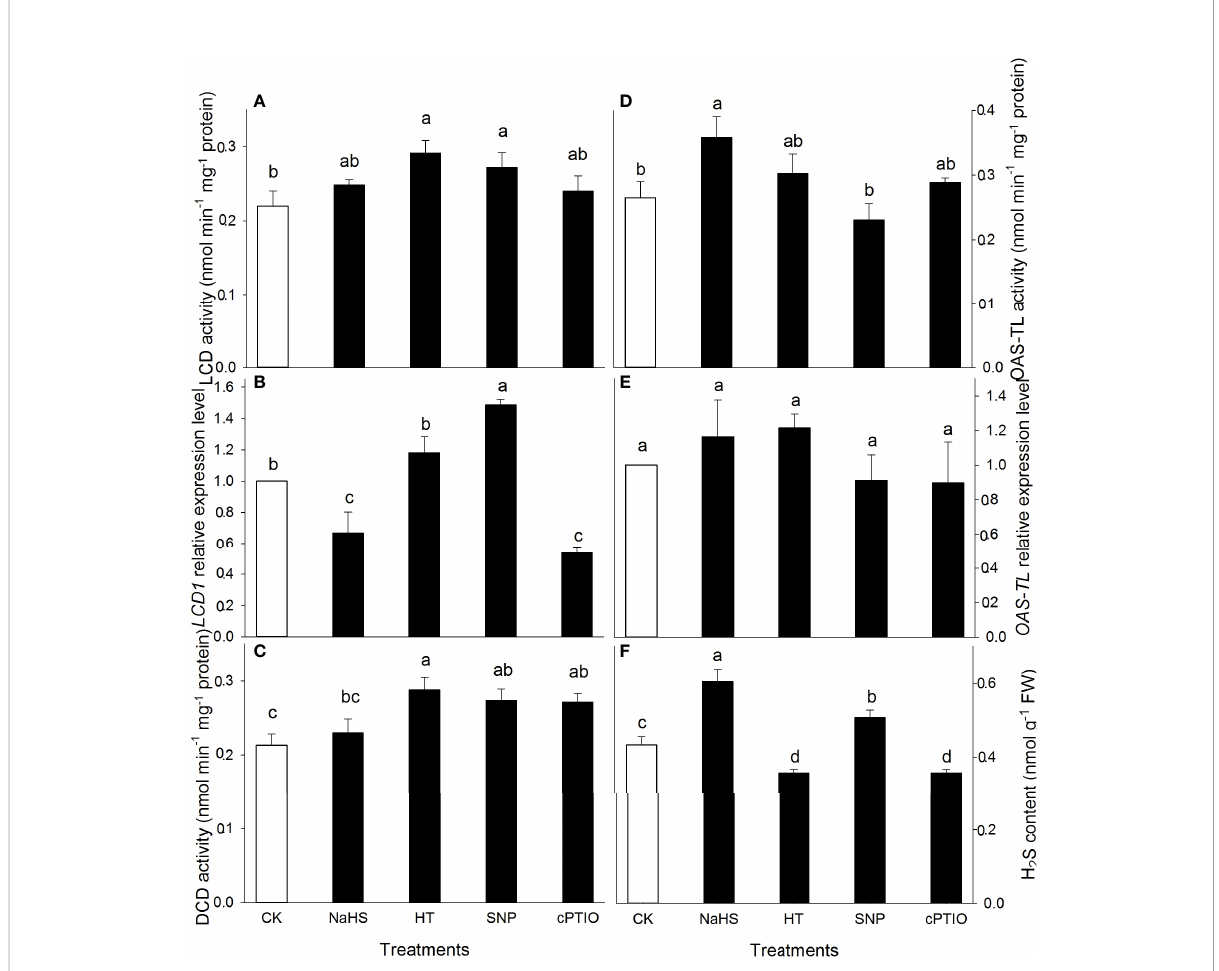
FIGURE 1 Effect of sodium hydrosul fi de (NaHS), hypotaurine (HT), sodium nitroprusside (SNP), and 2-(4-carboxyphenyl)-4,4,5,5-tetramethylimidazoline-1- oxyl-3-oxide (cPTIO) on L-cysteine desulfhydrase (LCD) (A) , D-cysteine desulfhydrase (DCD) (C) , O-acetylserine (thio) lyase (OAS-TL) (D) activities and corresponding gene expression (B, E) as well as hydrogen sul fi de (H 2 S) content (F) in maize seedlings under non-HS conditions. The data had at least three biological replicates and were tested using Duncan's multiple-range test at 0.05 signi fi cant level, which denote means ± standard error (SE). The bars with the different letters represent signi fi cant differences, while the same letters represent no signi fi cant